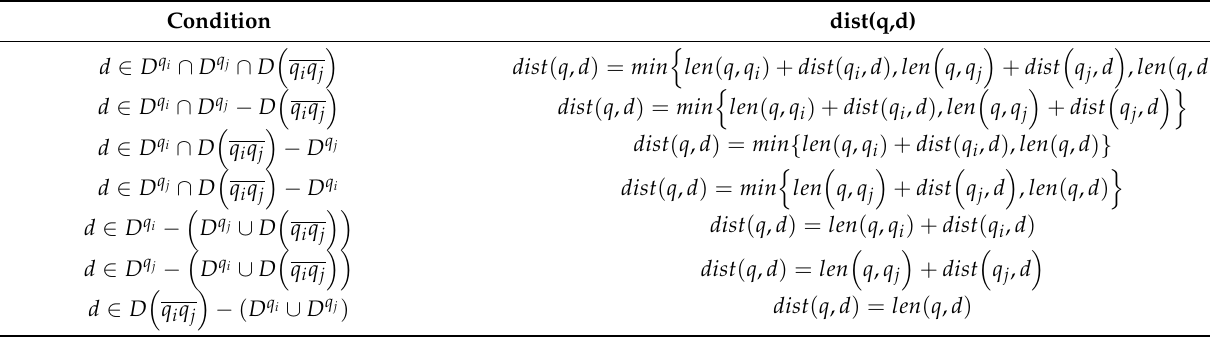
(cid:16) (cid:17) q i q j .